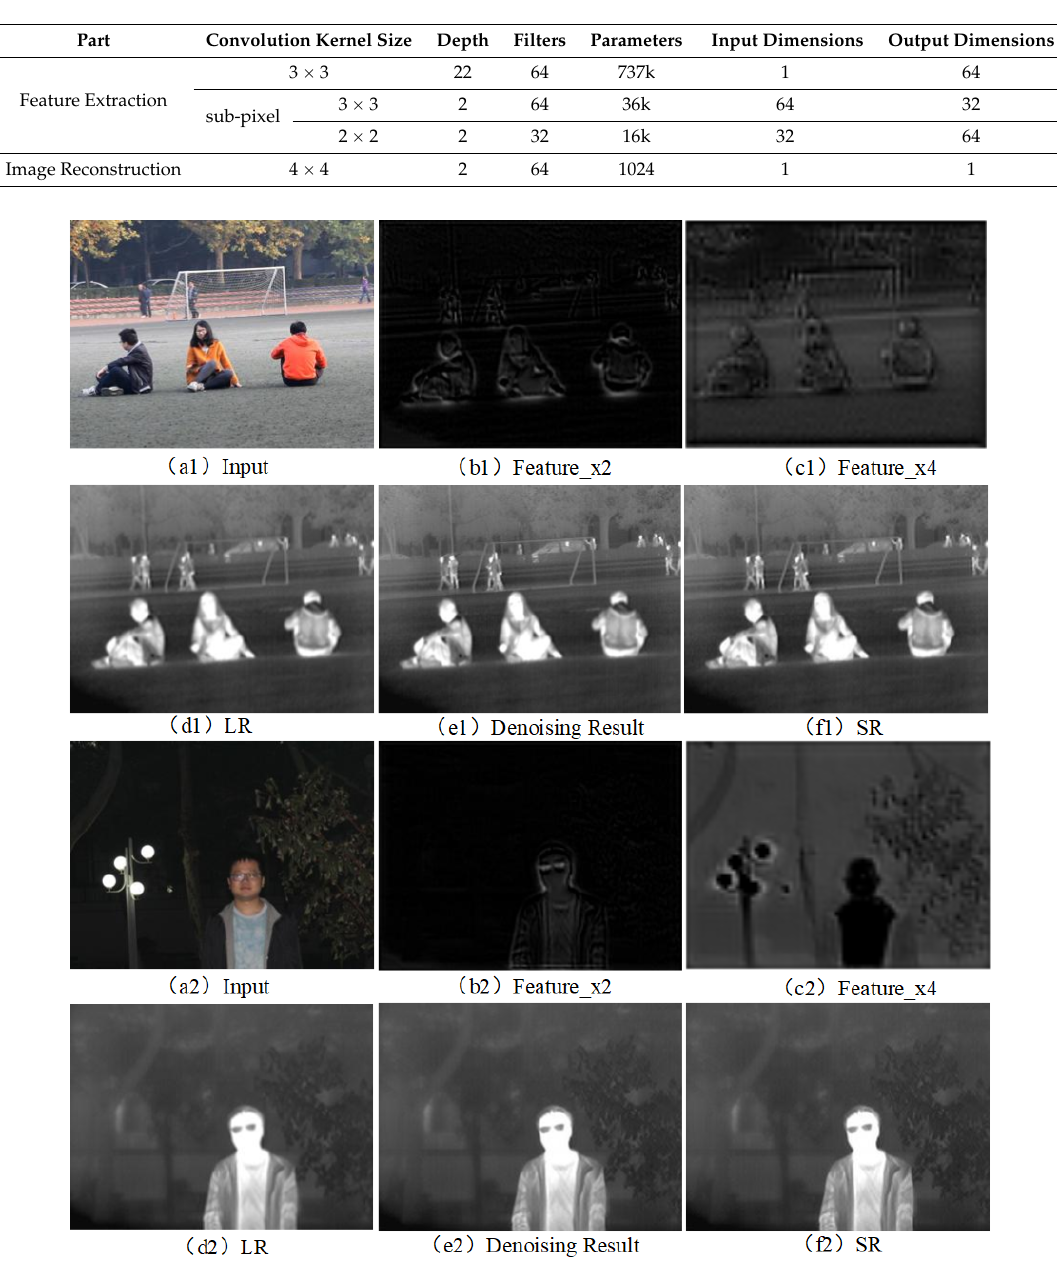
Figure 4. The input, output and intermediate layer image of RGB-IR cross input and sub-pixel upsampling network at ˆ 4 scale. ( a ) input RGB image, ( b ) feature image ˆ 2, ( c ) feature image ˆ 4, ( d ) input IR image, ( e ) denoising result, and ( f ) SR